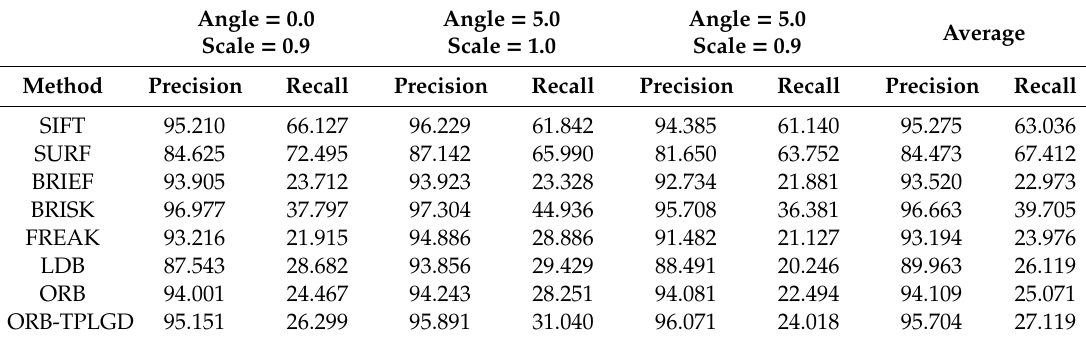
Table 8. Average matching precision and recall based on SAR dataset (%).